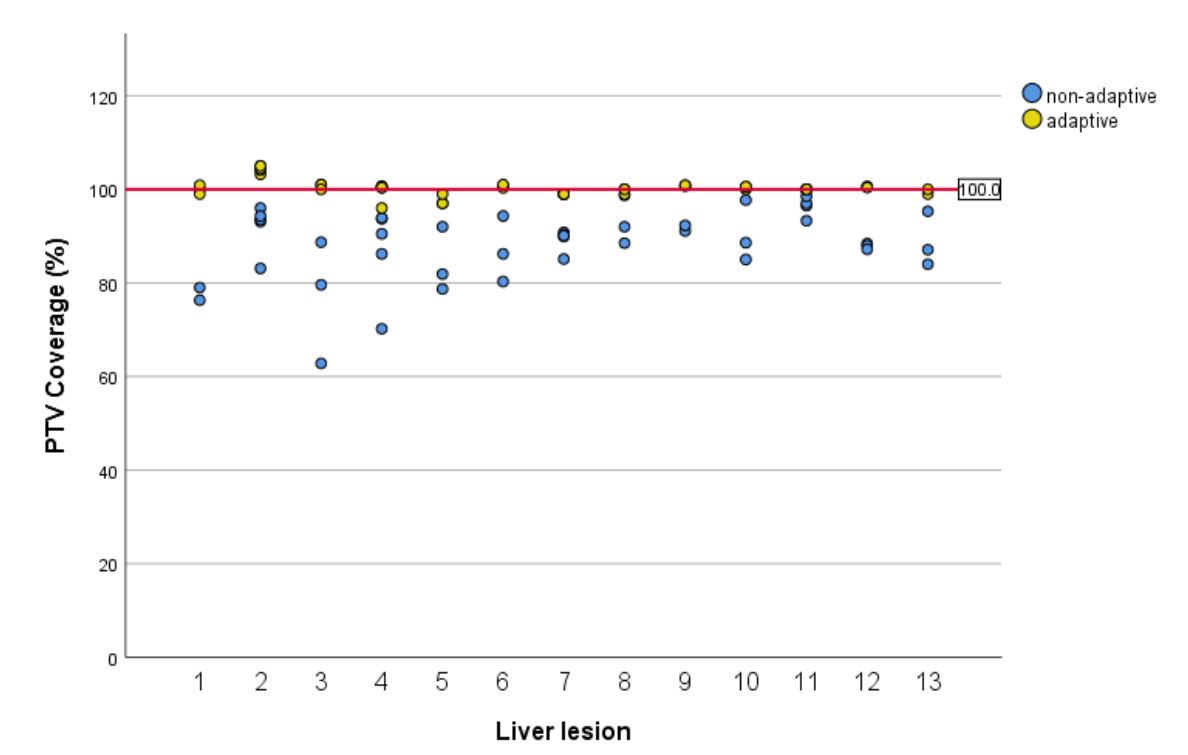
Figure 2. PTV coverage for adaptive and non-adaptive plans. The red horizontal line marks the prescribed level of target coverage. The Y-axis is a relative measure of the PTV coverage. Each dot shows the calculated dose in relation to the prescribed dose.